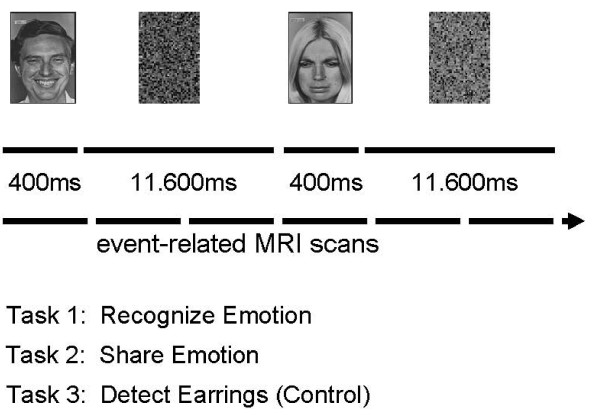
Schematic illustration of the experimental design.